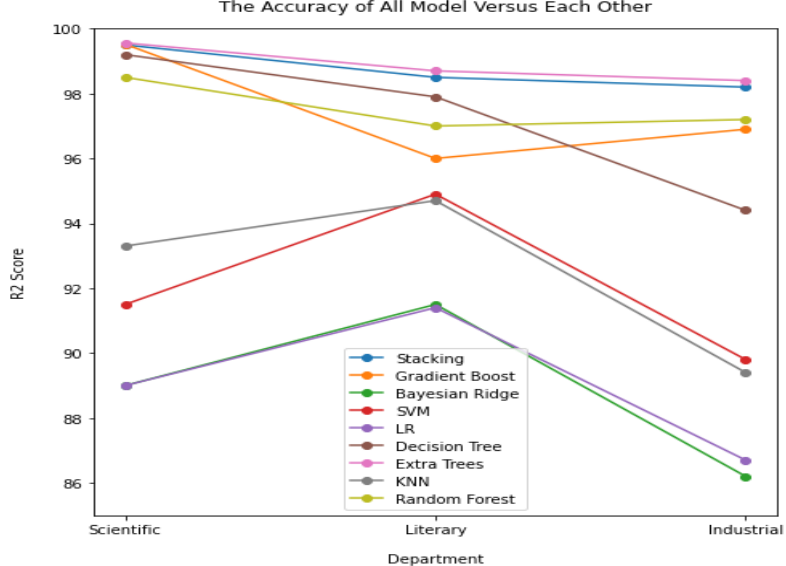
Figure 2. Accuracy of all tested models. SVM = Support Vector Machine, LR = Linear Regression, KNN = K-Nearest Neighbor.